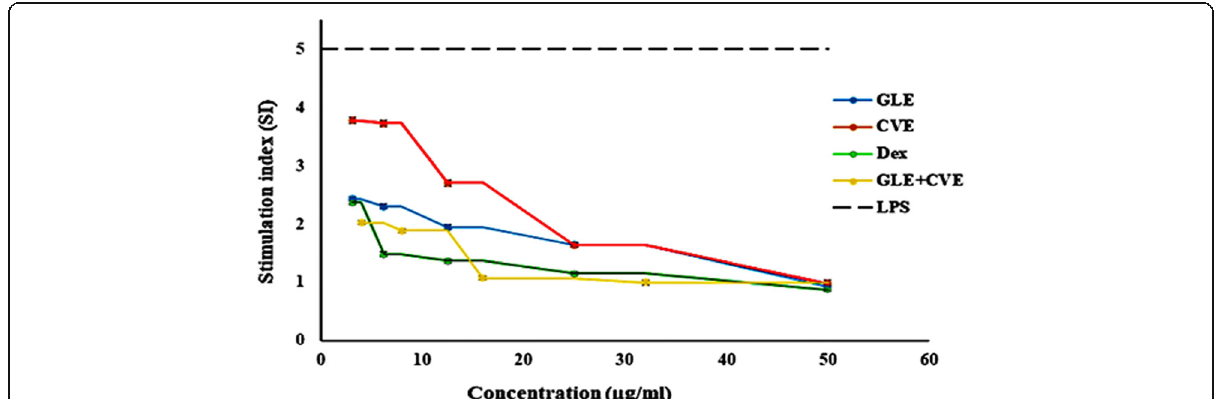
Fig. 3 Effect of serial concentration of GLE, CVE, GLE-CVE combination, and Dex on the abnormal proliferation of LPS-exposed WBCs in the term of SI. Results are expressed as Mean ±